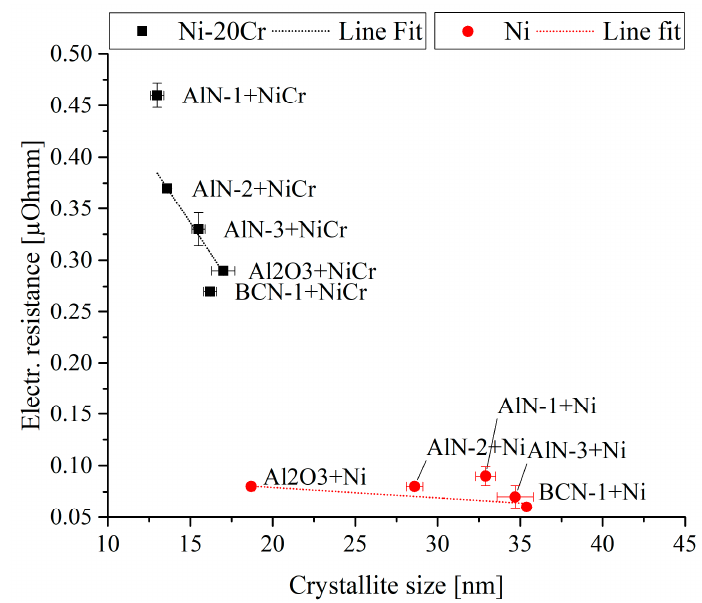
Figure 7. Influence of the substrate layer on the crystallite size and electrical resistance of Ni and Ni-20Cr thin films.